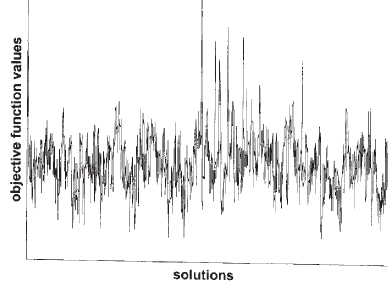
Figure 4. Example of a complex